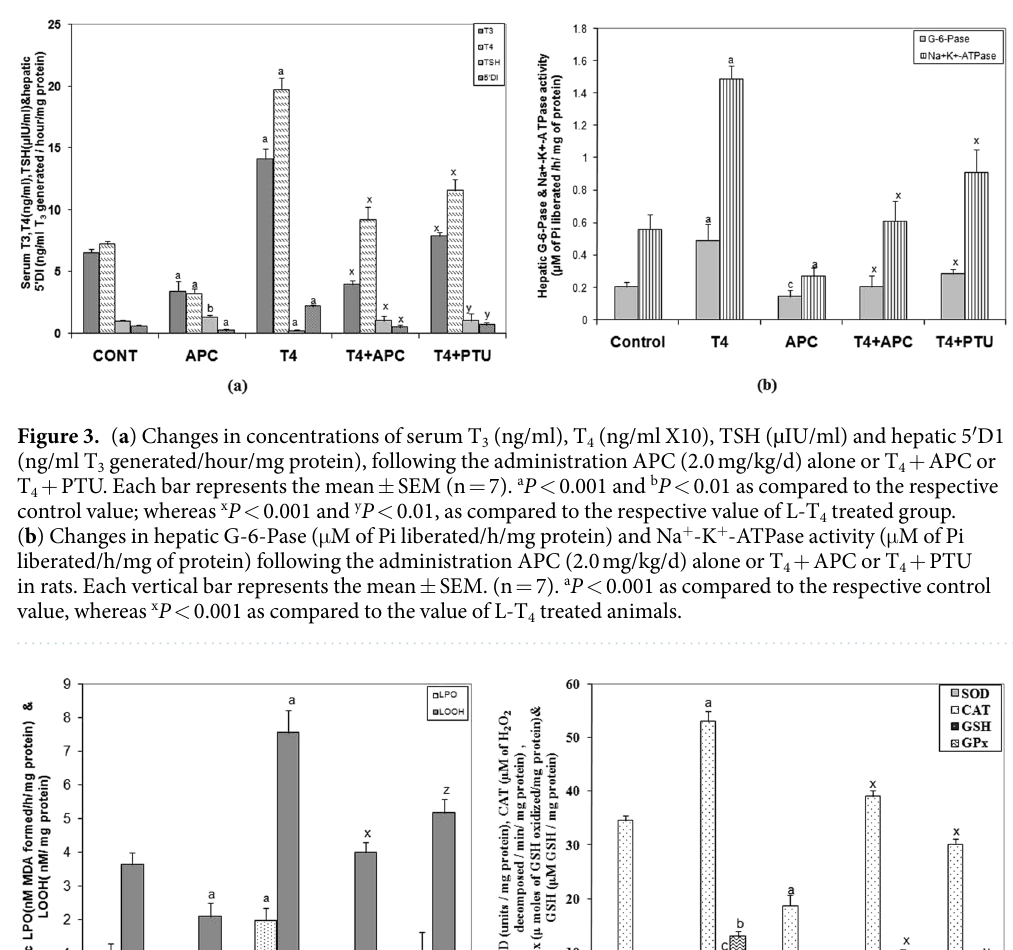
their concentrations were decreased significantly in T 4 + APC and in T 4 + PTU treated animals as compared to that of L-T 4 -induced rats (Table 1).